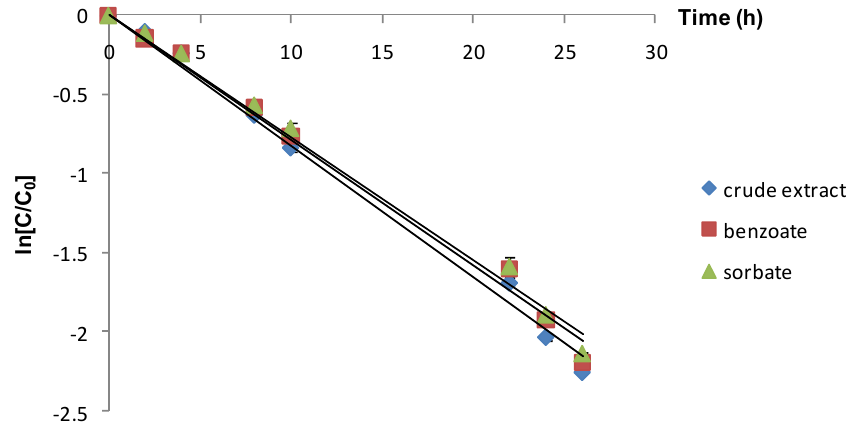
Figure 3. Influence of different food preservatives on the anthocyanin stability during storage at 75 °C (vertical lines represent SD, n = 4).